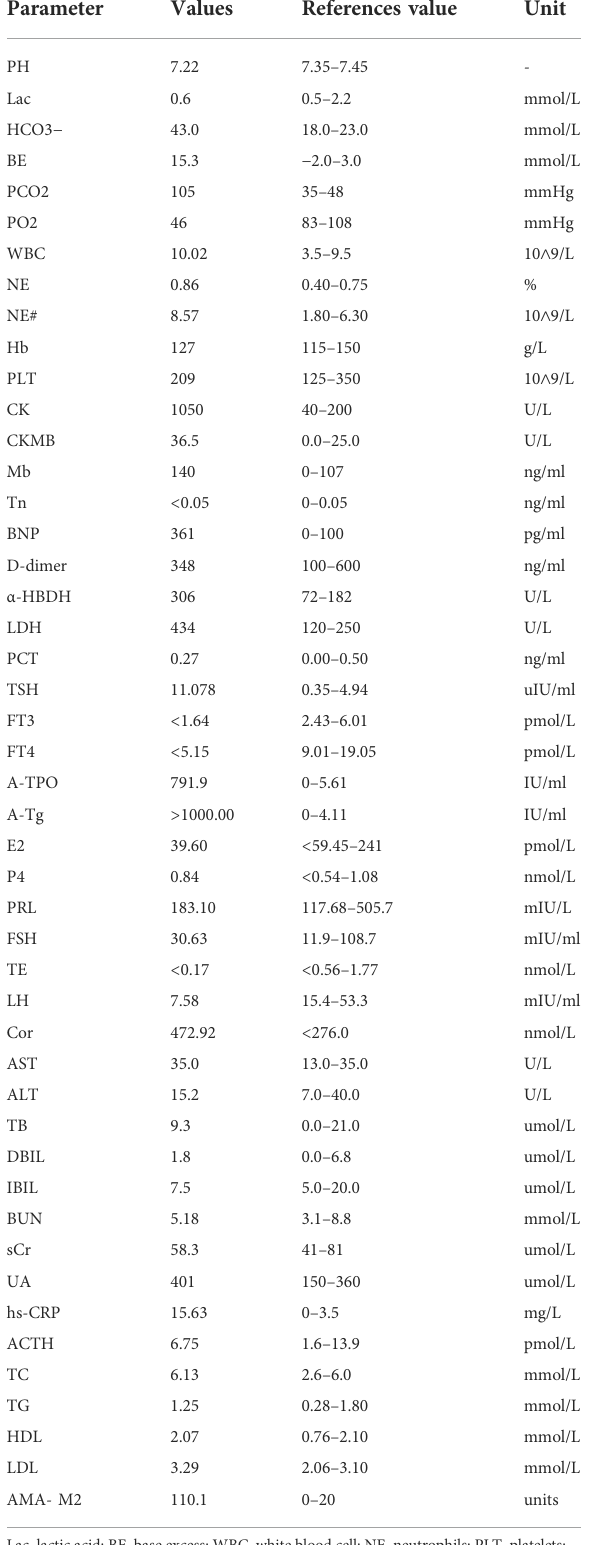
TABLE 1 The patient ’ s laboratory